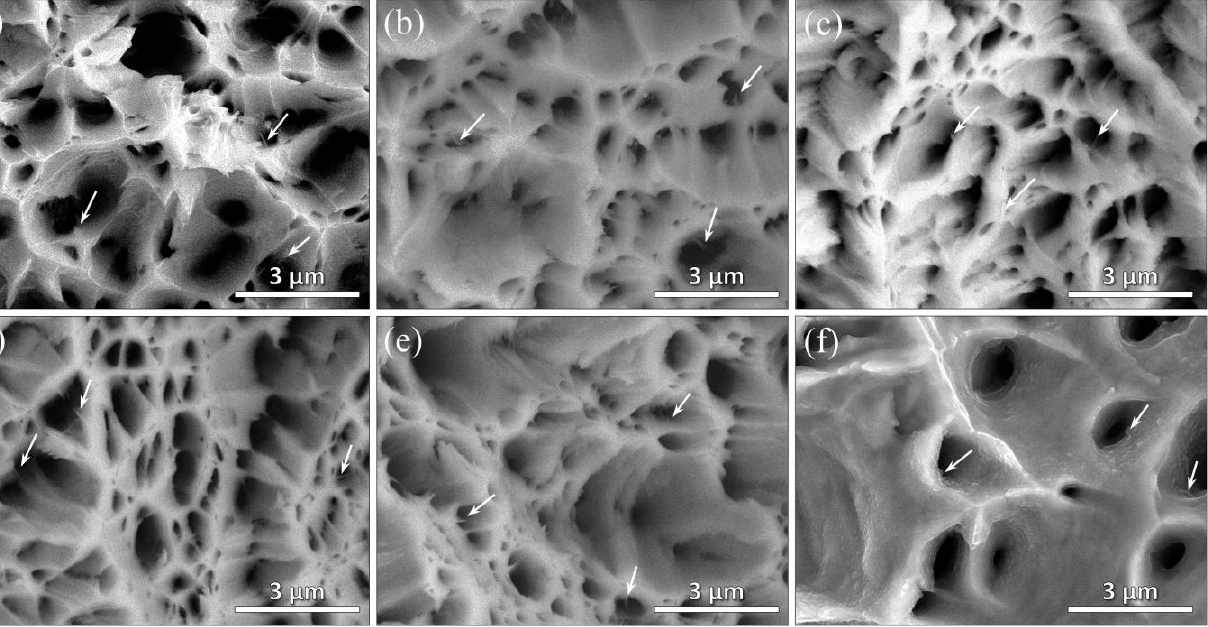
composites with different drawing reductions. Figure S2: Grain boundaries distribution of the (a) as-sintered, (b) as-extruded, and as-drawn composites with different drawing reductions. Figure S3: Pole figure and inverse pole figure of the as-extruded composite, ED indicates the extrusion direction.